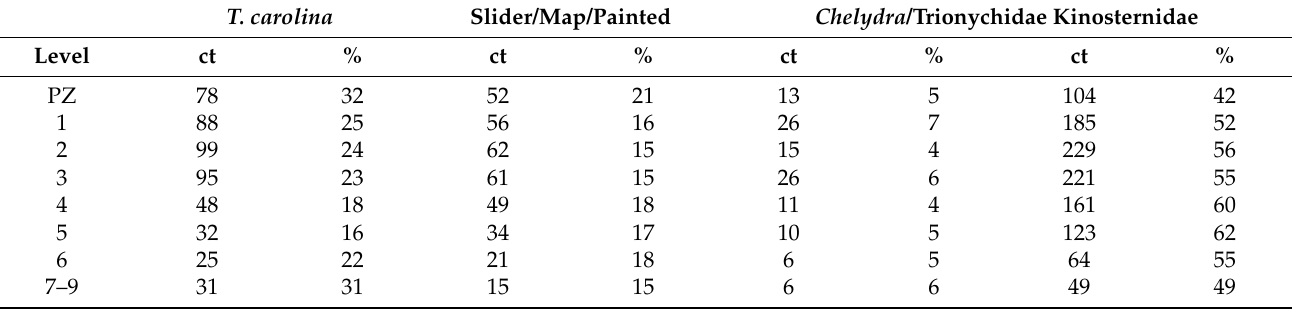
Table 5. Combined taxon counts and percentage by